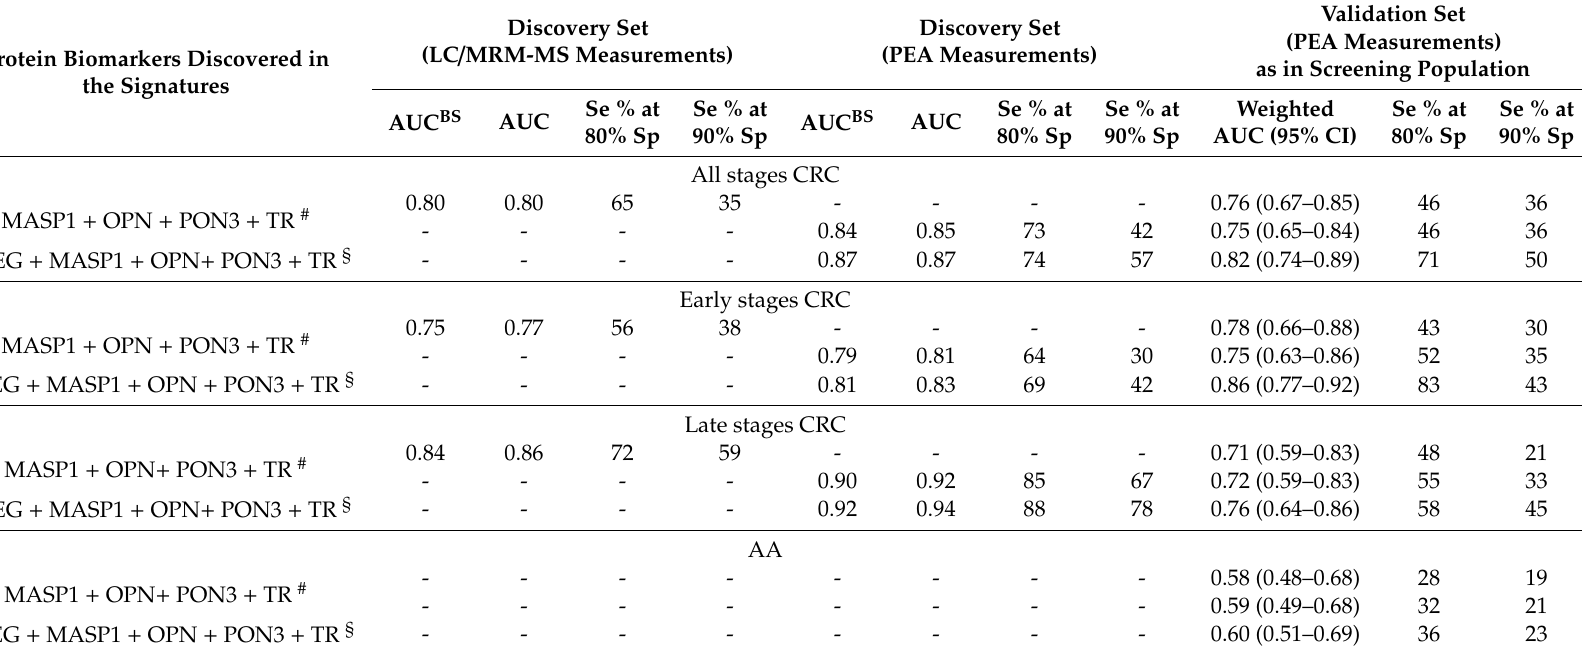
Table 3. Diagnostic performance of multimarker signatures for detecting CRC (all stages / early / late) and AA.